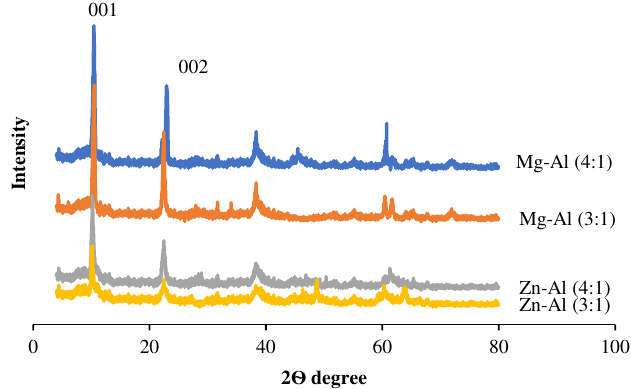
Fig. 1: XRD analysis of Mg-Al (4:1), Zn-Al (4:1), Mg-Al (3:1) and Zn-Al (3:1) synthesized LDHs